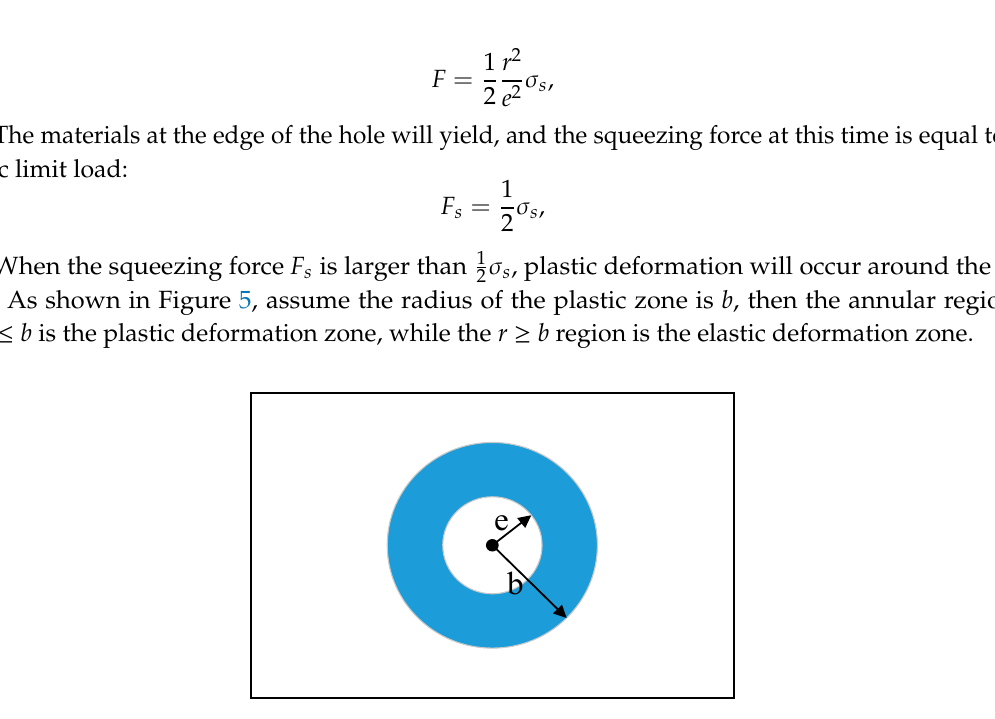
Figure 5. Elastic and plastic deformation zones around the rivet hole. e : Inner radius of the plastic zone and b : Outer radius of the plastic zone.